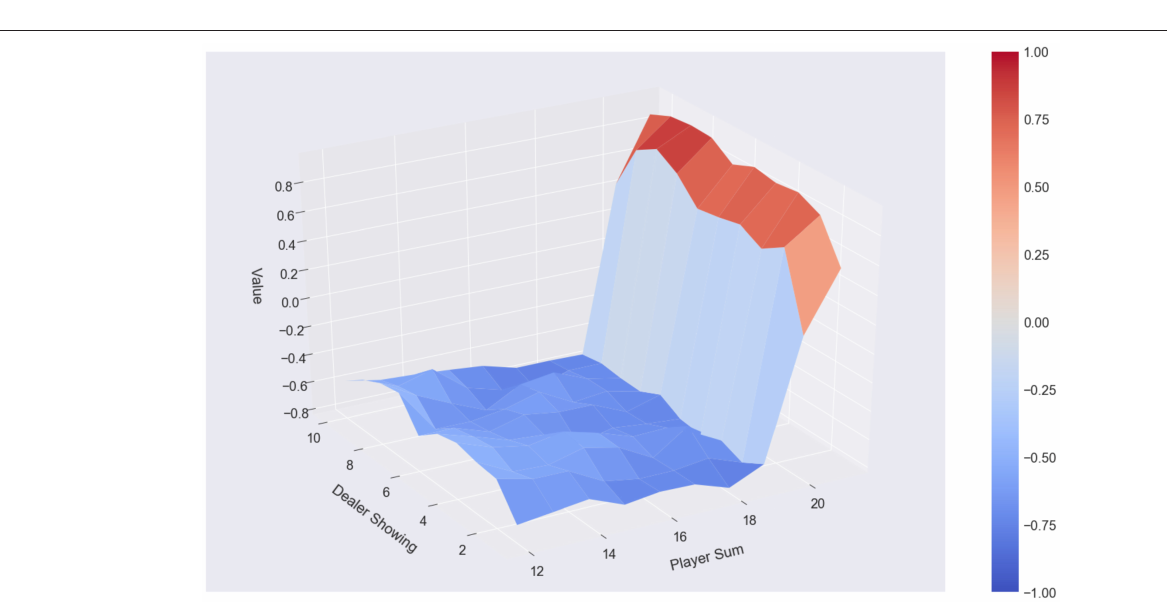
Frontiers in Physics |